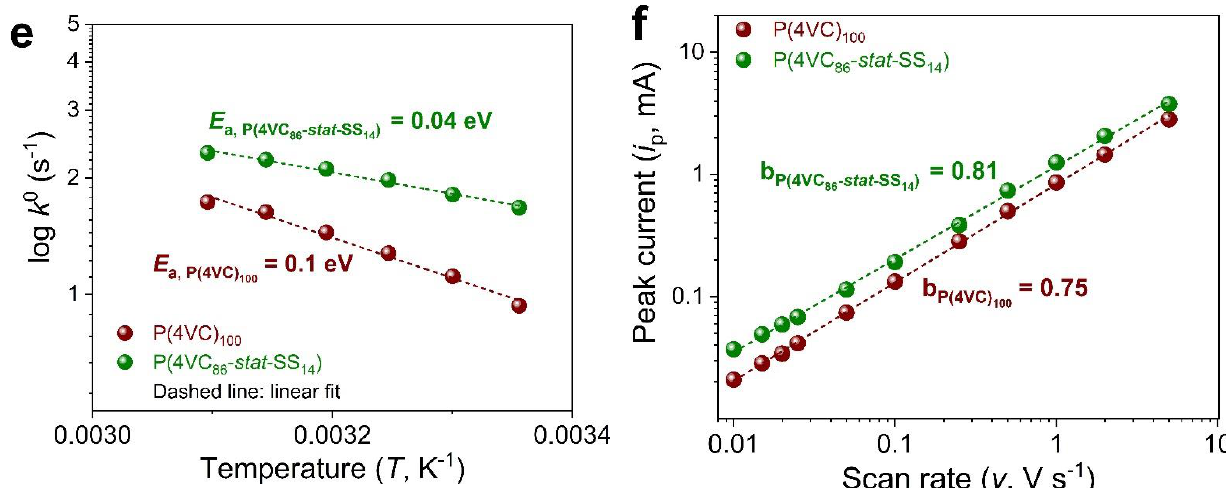
Figure 4. Comparative electrochemical kinetic analyses of redox reaction between P(4VC) 100 and P(4VC 86 - stat -SS 14 ). ( a ) Nyquist plots, and ( b ) plots showing the correlation between real (Z′)-part of complex impedance and ω −1/2 in the semi-infinite diffusion region to calculate the apparent diffusion coefficient in full-cells. ( c , d ) Variation of anodic and cathodic peak positions (Ep), and peak separation (ΔEp) as a function of the scan rate (in logarithmic scale) to calculate rate constant. ( e ) A fitting of temperature dependence of rate constant with the Arrhenius equation to calculate activation energy. ( f ) Peak current vs. scan rate in logarithmic scale for the cathodic peak to obtain b-values according to i p = a v b .